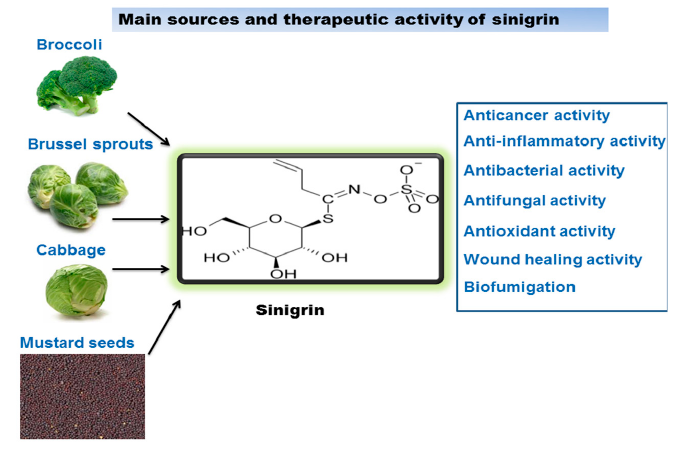
Figure 2. Sinigrin sources and its therapeutic activity